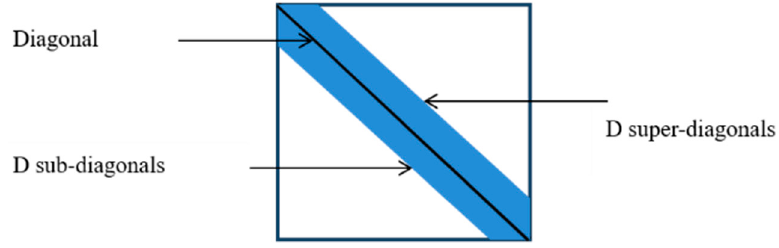
contains main diagonals and two D off ‐ diagonals (super and sub) extracted from 𝑯 𝒏,𝒎 (cid:4666)𝒃(cid:4667) , while 𝑯 𝒓𝒏 is the interference, including the ICI beyond the “ICI span” and additive noise.